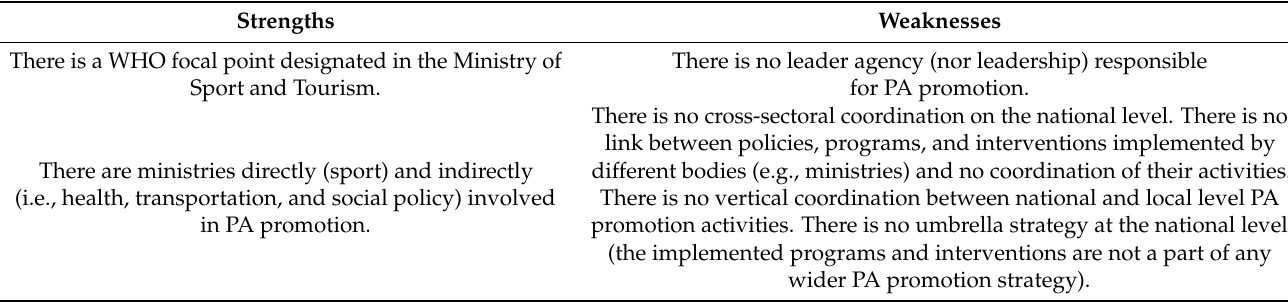
Table 5. SWOT analysis of PA promotion in